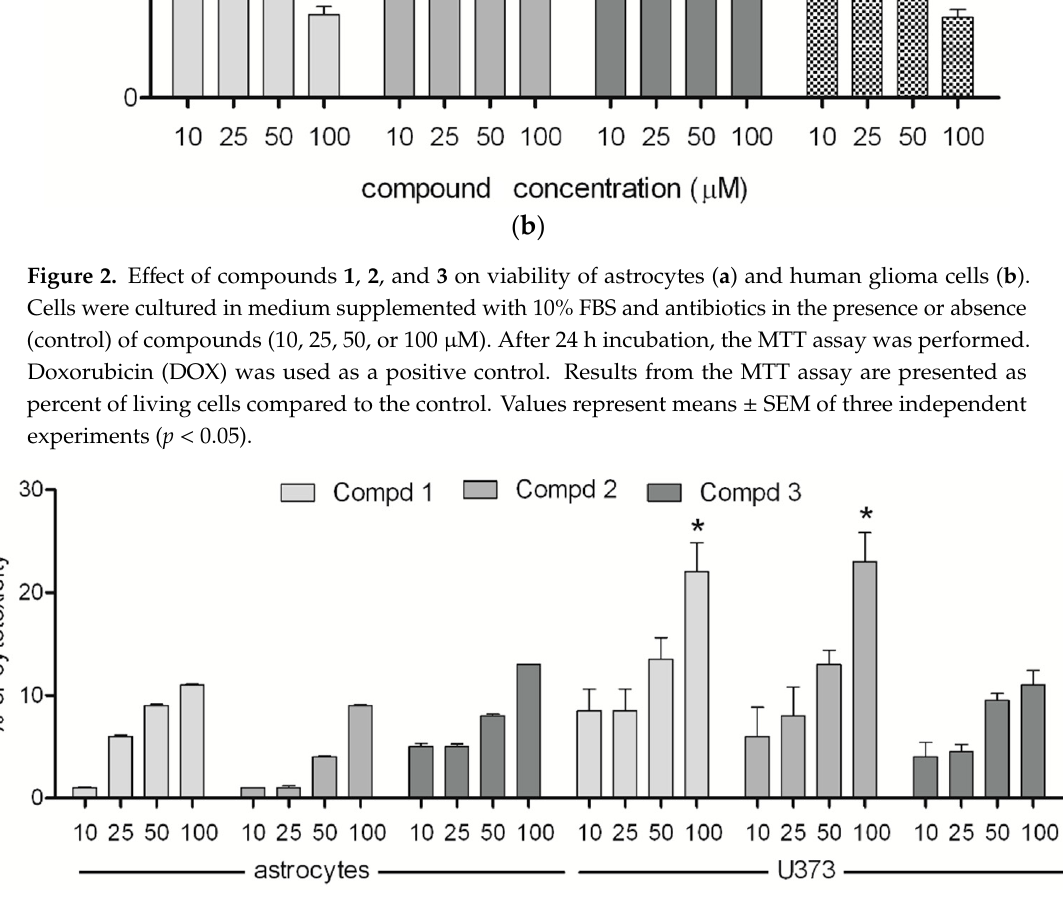
Figure 3. Cytotoxicity of compounds 1 , 2 , and 3 on astrocytes and human glioma cells. Cells were cultured in medium supplemented with 10% FBS and antibiotics in the presence of compounds (10, 25, 50, or 100 µM). Results from LDH assays show the percent of cytotoxicity compared to the control. Values represent means ± SEM of three independent experiments ( p < 0.05).